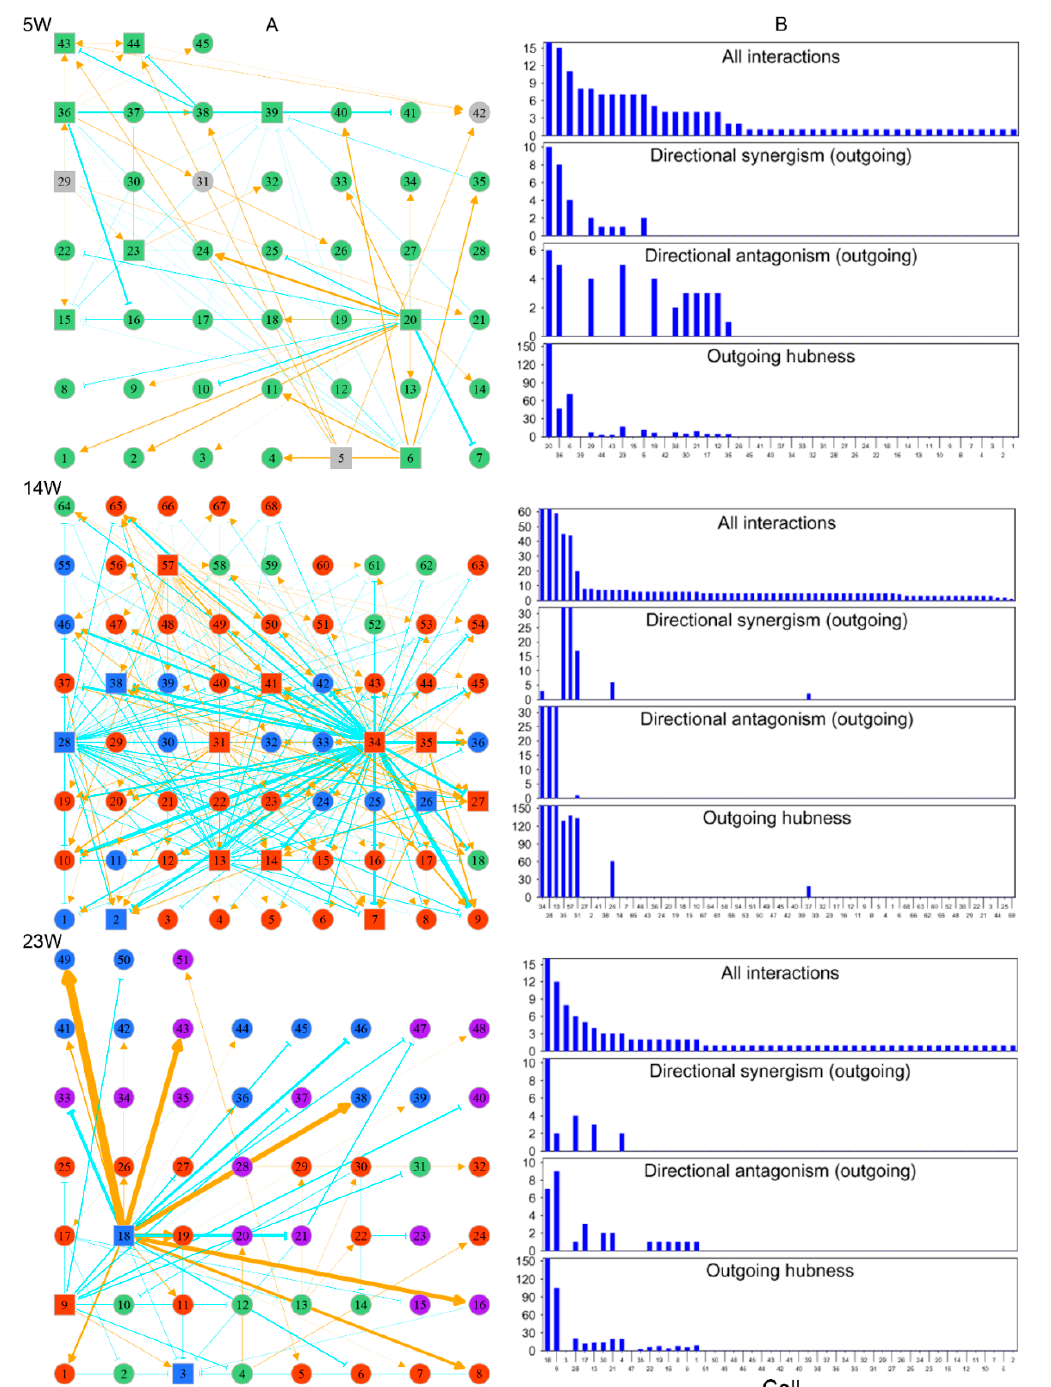
Figure 9. Networks of cell–cell interactions, guided by genes, at three different stages of embryo development (5, 14, and 23 weeks post-fertilization). ( A ) Topologies of time series of networks among randomly sampled cells. Cells in different FGC phases (determined by biomarkers) denoted with colored circles or squares (standing for hubs): green for mitosis, dark red for RA-responsive phase, light blue for meiosis, and purple for oogenesis. Gray color indicates cells whose phase cannot be determined. Yellow-orange arrowed lines and blue-green T-shaped lines denote promotion and inhibition, respectively. ( B ) The distribution of the number of all interactions, outgoing directional synergism, and outgoing directional antagonism and outgoing hubness across FGCs within the 5-week, 14-week and 23-week